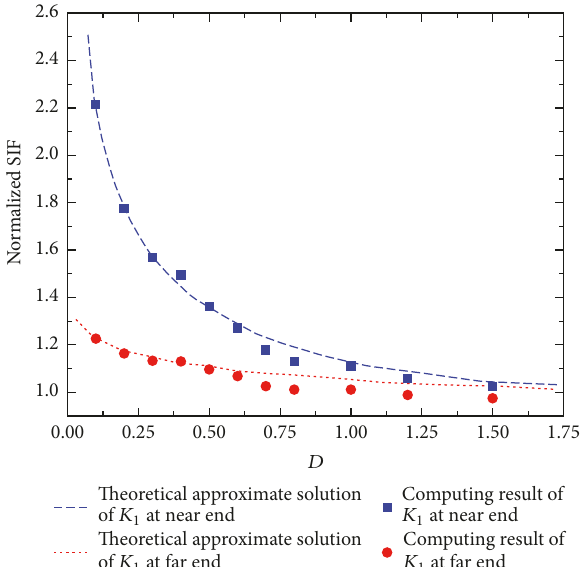
Figure 5: The comparison between the result from the 3D model in Figure 4 and the 2D theoretical solution.